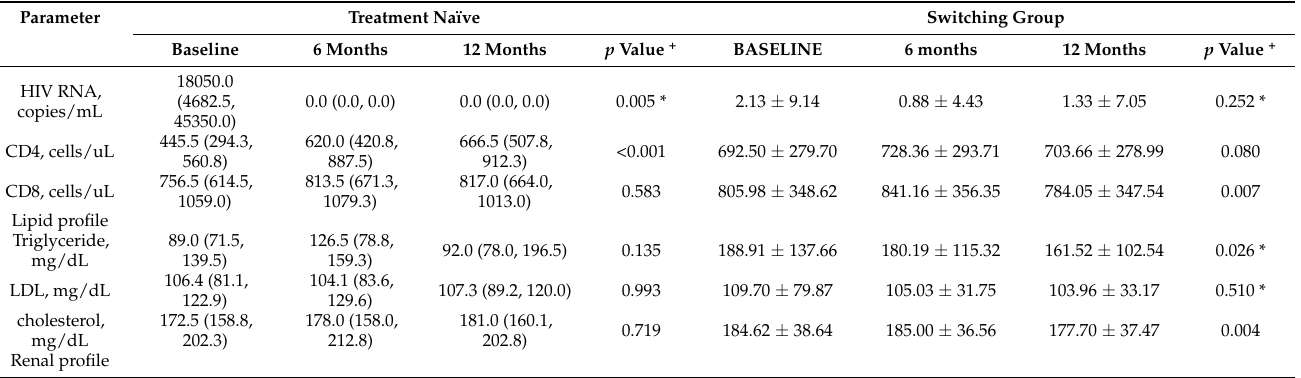
Table 4. Laboratory parameters at between baseline and 6 and 12 months for the treatment-naïve and switching